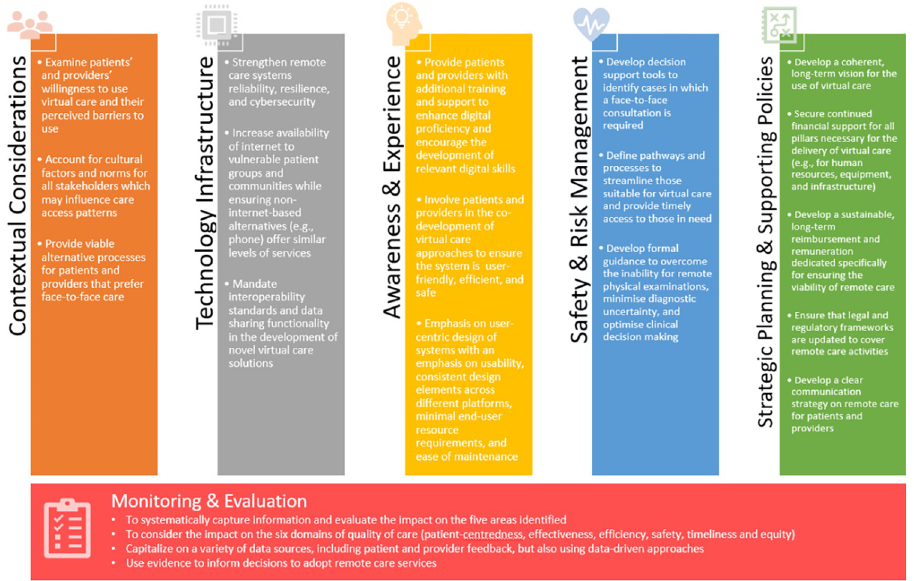
Fig 3. Summary of recommendations for the implementation of virtual consultations in the primary care